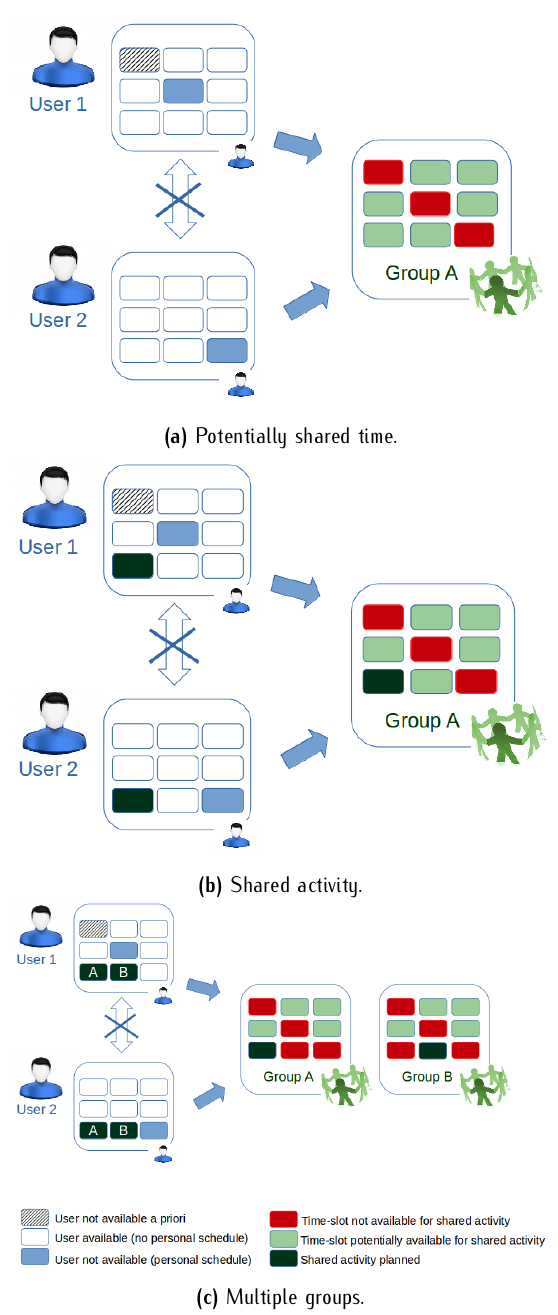
Figure 2. Overview of the model behaviour.